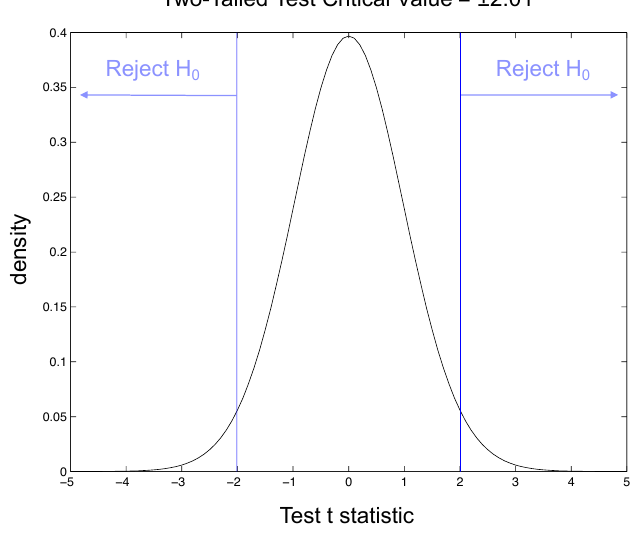
Figure 13. Rejection regions for two-tailed t -test with α =